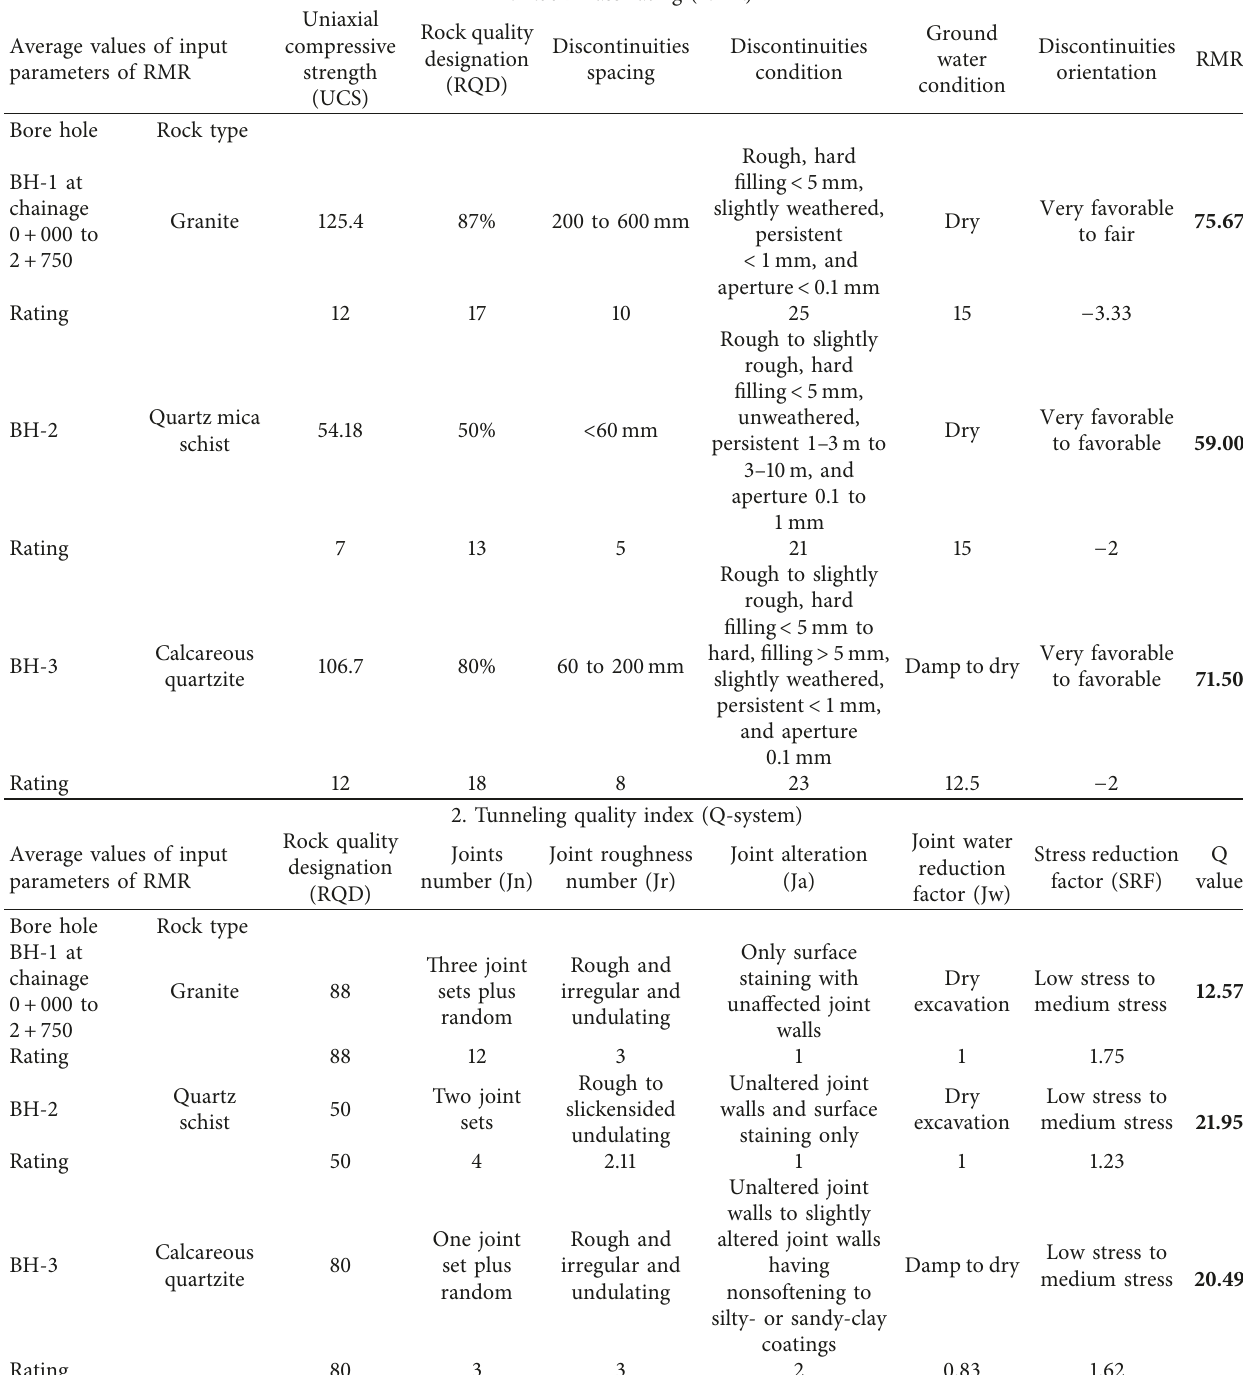
Table 1: Results of rock mass classification. 1. Rock mass rating